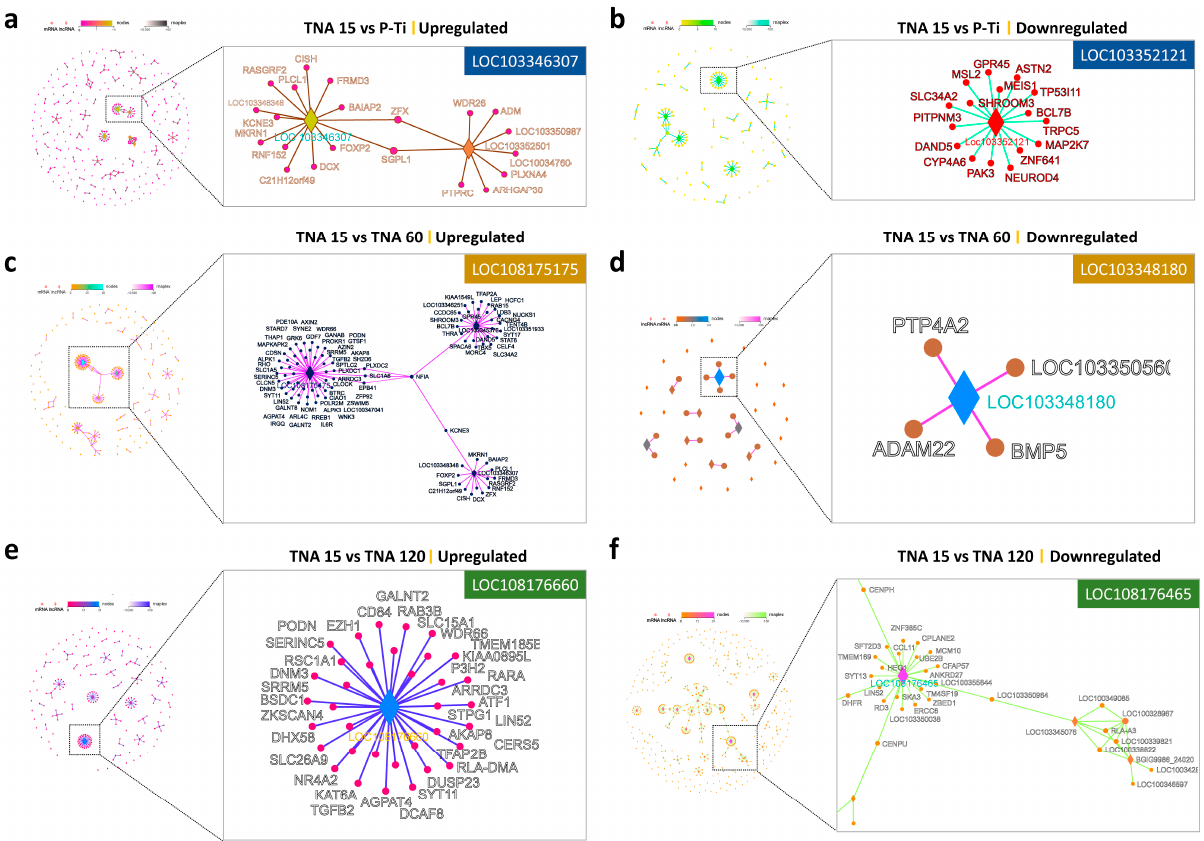
Figure 4. Visualization of different LncRNA expression profiles with heatmap. ( a ) P-Ti vs. TNA 15. ( b ) TNA 60 vs. TNA 15. ( c ) TNA 120 vs. TNA 15. Quantitative results of the LncRNA expression profiles. ( d ) P-Ti vs. TNA 15. ( e ) TNA 60 vs. TNA 15. ( f ) TNA 120 vs. TNA 15. Figure 5 indicates key LncRNAs involved in the regulation of LncRNA-mRNA among groups. LOC103346307, LOC108175175, and LOC108176660 targeted most of the upregulated mRNAs in TNA 15 compared with P-Ti, TNA 60, and TNA 120, respectively, whereas LOC103352121, LOC103348180, and LOC108176465 targeted most of the downregulated mRNAs.